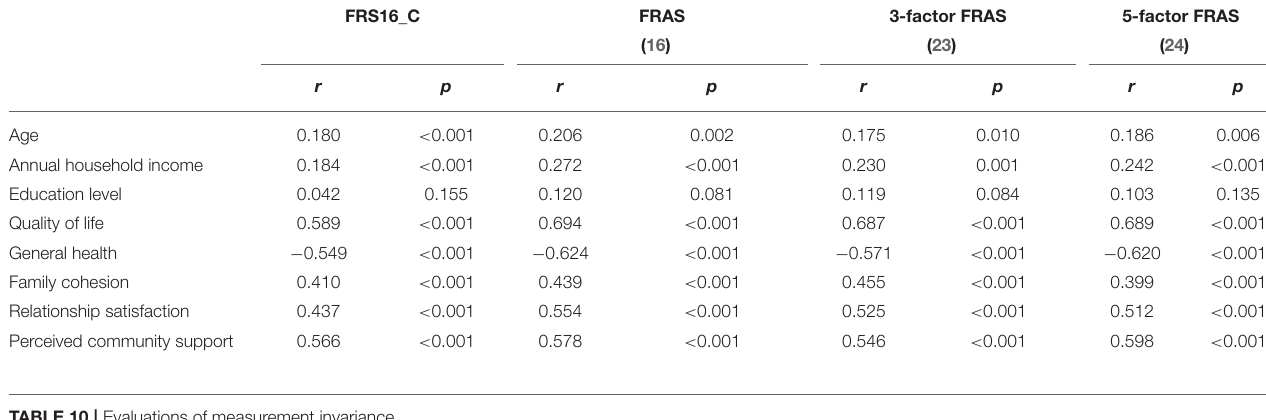
TABLE 9 | Correlations of FRASs and FRS16_C with demographic and outcome variables.